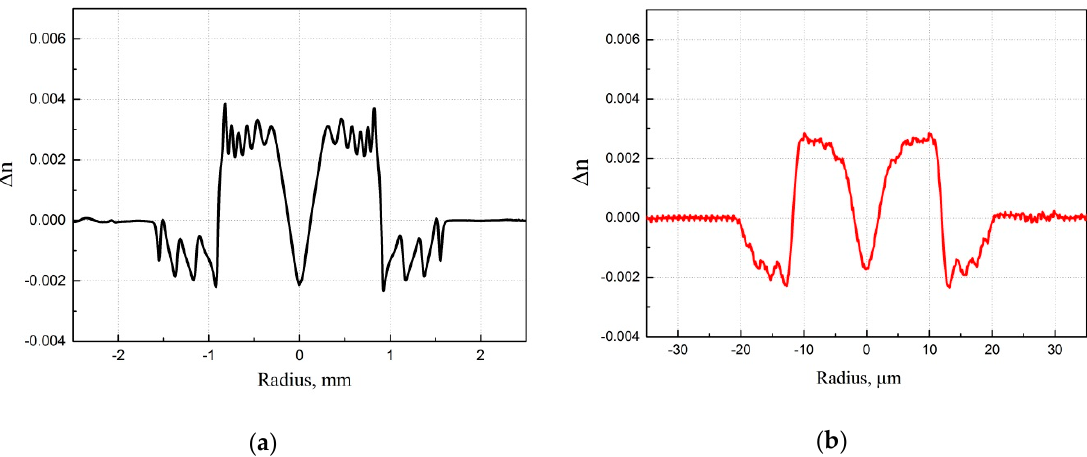
Figure 5. The refractive index profiles (RIPs) measured in a preform ( a ) and in a corresponding fiber ( b ). The preform with an Er–Yb–FPS glass core was manufactured by the improved all-gas-phase deposition technique (ASL-116).